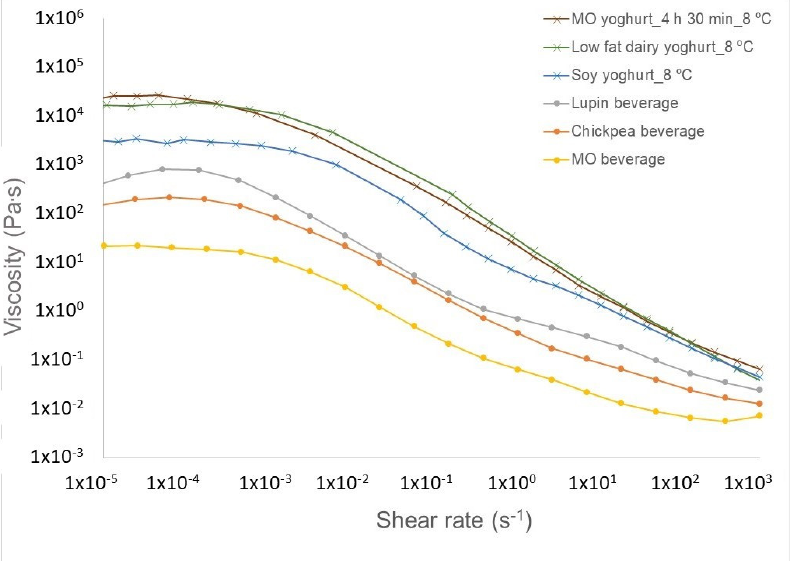
Figure 2 . Flow curves showing the shear viscosity profile for the MO-based beverage and yoghurt- type compared to lupin- and chickpea-based beverages, and also to commercial soy and low fat dairy yoghurt, respectively.